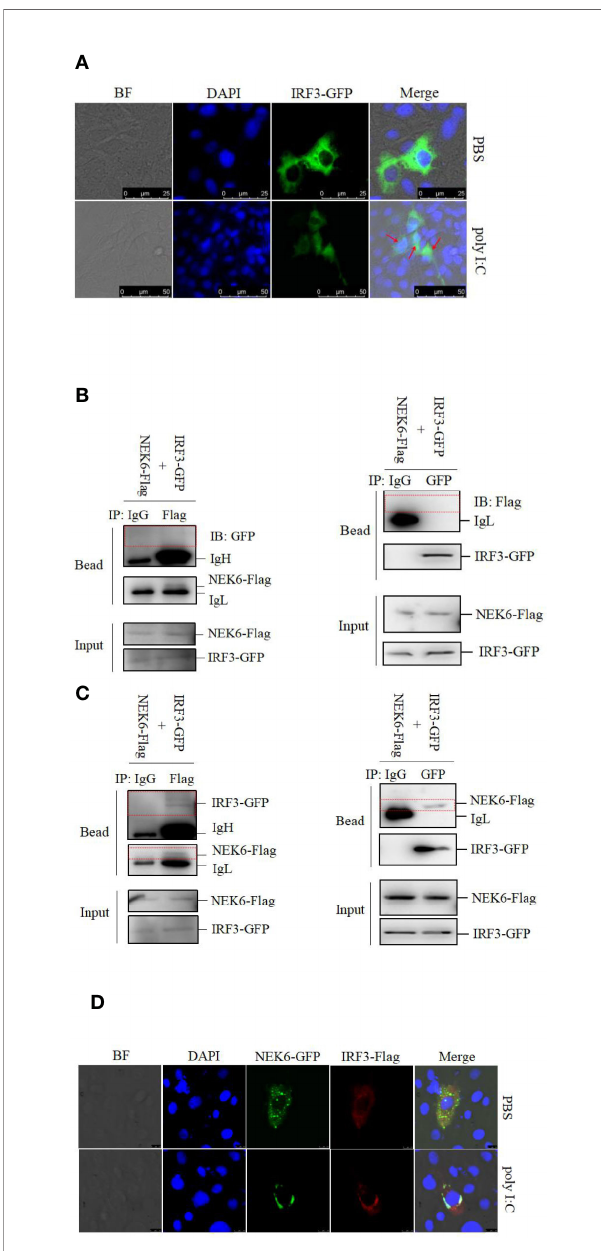
FIGURE 6 | CiNEK6 interacts with CiIRF3 in the cytoplasm. In subcellular localization of IRF3, CIK cells were transfected with 2 m g of IRF3-GFP. Then, the cells were treated with PBS or poly I:C. The subcellular localization of IRF3 in CIK cells was imaged by a confocal microscope (A) . The scale bar is 25 µm. Magni fi cation of cells is × 400. In co-IP assay, the plasmids of NEK6-Flag and IRF3-GFP were co-transfected into CO cells. At 24 h post-transfection, the cells were treated with PBS (B) or poly I:C (C) . Each group was divided into two panels. Left panel of immunoprecipitation was conducted by anti-GFP antibody and right panel was anti-Flag antibody. The immunoprecipitation of IgG was selected as a negative control. The molecular weight of NEK6-Flag, IRF3-GFP, IgH and IgL are 38, 85, 58, and 35 kD, respectively. In co-localization assay, 2 m g of NEK6-GFP and 2 m g of IRF3-Flag were co-transfected into CIK cells. At 24 h post-transfection, the cells were treated with PBS or poly I:C. The co-localization of NEK6 and IRF3 was imaged by a confocal microscope (D) . The scale bar is 75 µm. Magni fi cation of cells is ×400.